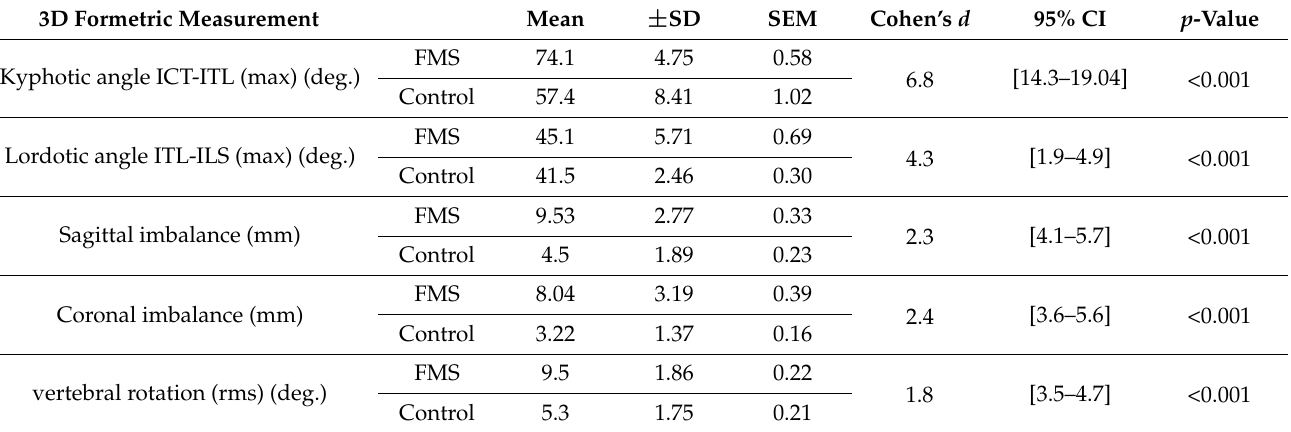
Table 2. Means, standard deviation (SD), 95% confidence interval (CI) and statistical significance of the postural measurements between participants with FMS and controls.